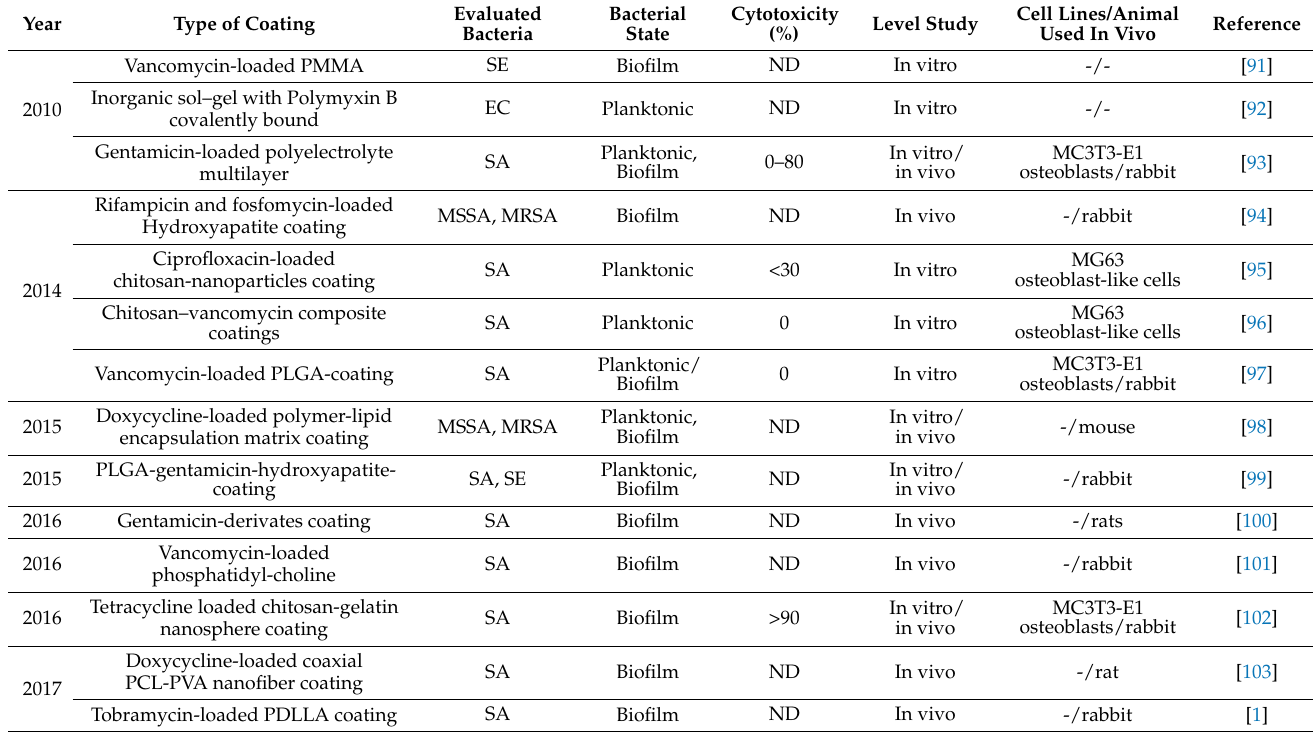
Table 3. Some of the most relevant studies based on antibiotic loaded coating for titanium